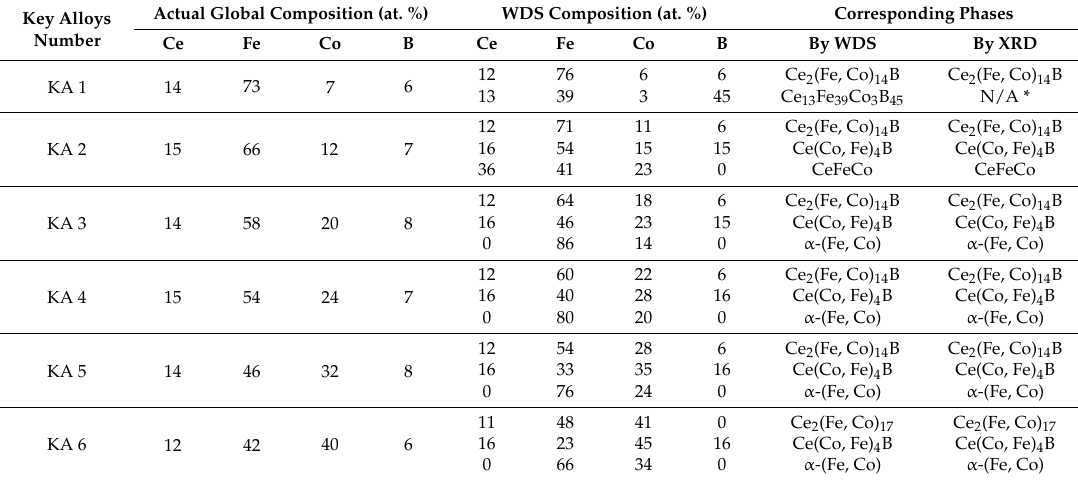
Table 2. Chemical composition of key alloys and detected phases.